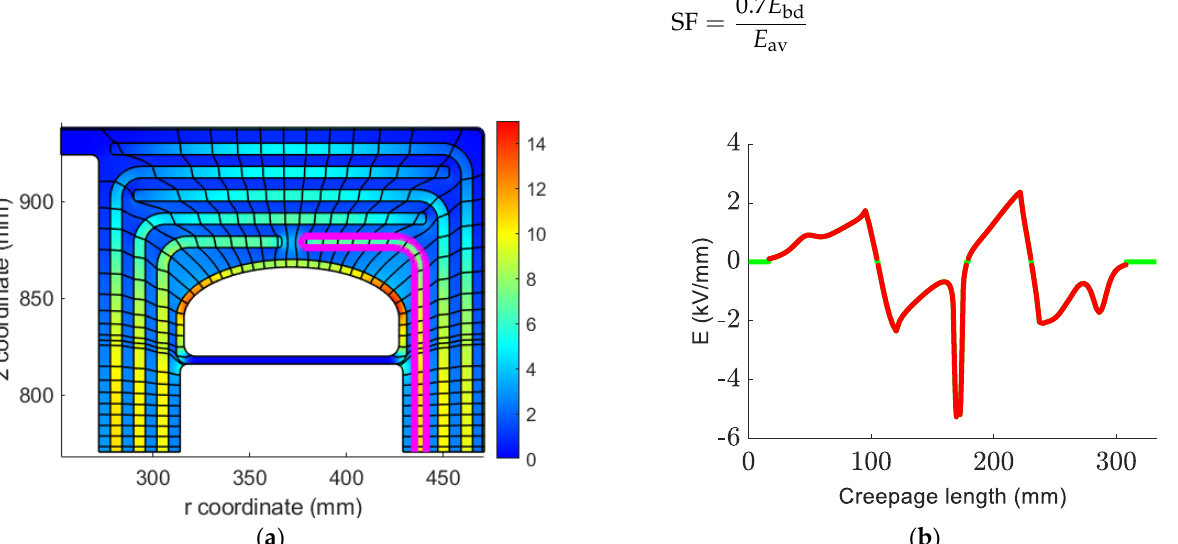
Figure 12. The streamlines by using ester oil at 10 s and 30 °C: ( a ) A sample creepage surface (thick pink line); ( b ) The electric field curve along this creepage surface (accounted from the right bottom).